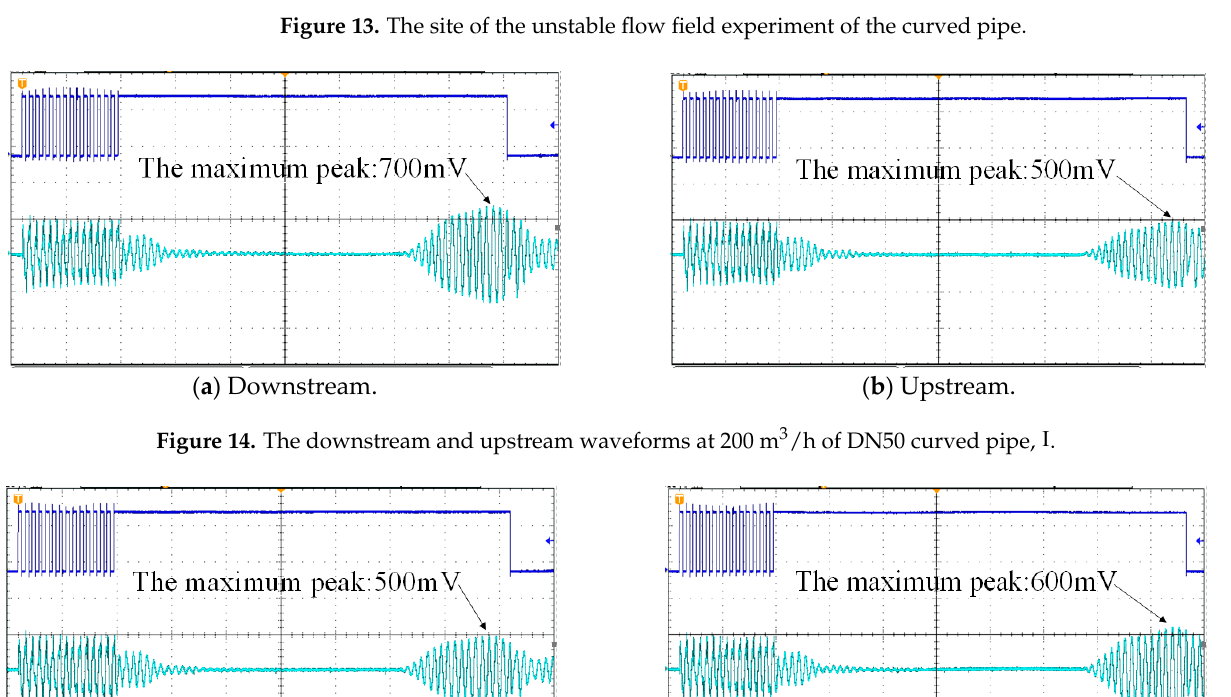
( a ) Downstream. ( b ) Upstream. Figure 15. The downstream and upstream waveforms at 200 m 3 /h of DN50 curved pipe, Ⅱ . After the gas flow standard device is connected to the curved pipe, the flow rate is changed and set to 10 m 3 /h, 73 m 3 /h, and 200 m 3 /h, respectively. The experiment is carried out at these three flow rates. The experimental results are shown in Table 3. The standard pulse coefficient of the meter was set to 3 pulse/m 3 . Table 3. E xperimental results of unstable flow field experiment of the DN50 curved pipe. Flow Rate(m 3 /h)